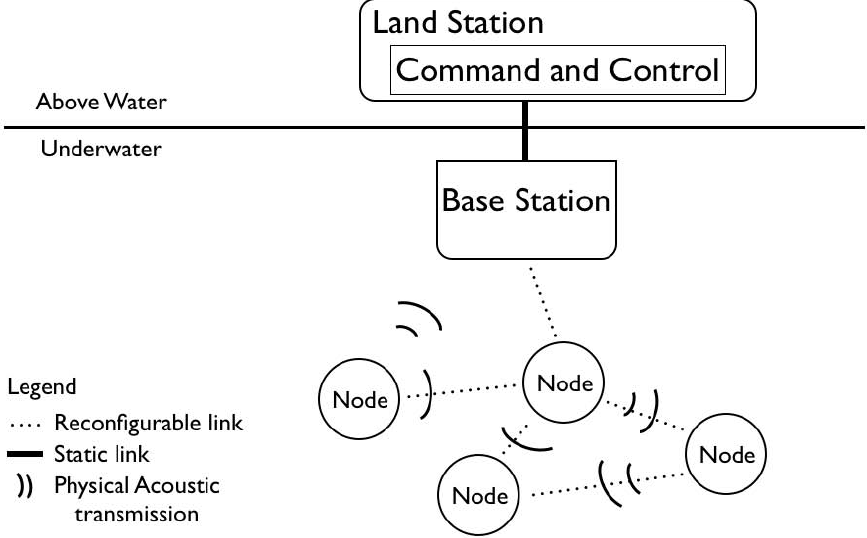
Figure 3. Architecture diagram with spatial configuration of various fixed and mobile nodes as well as the base station with the command and control